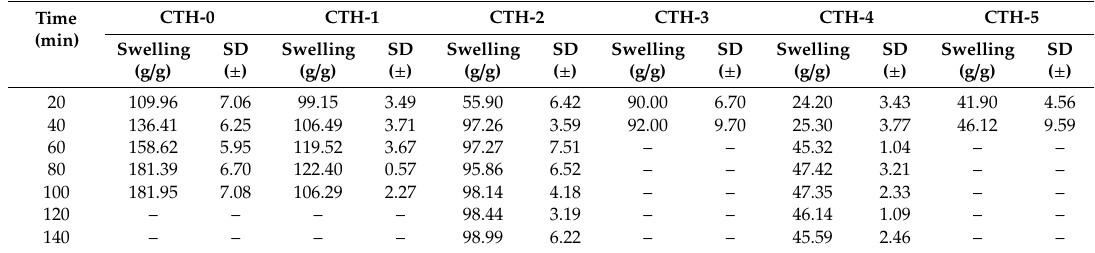
Table 3. Swelling data of CS / PAH films in deionized